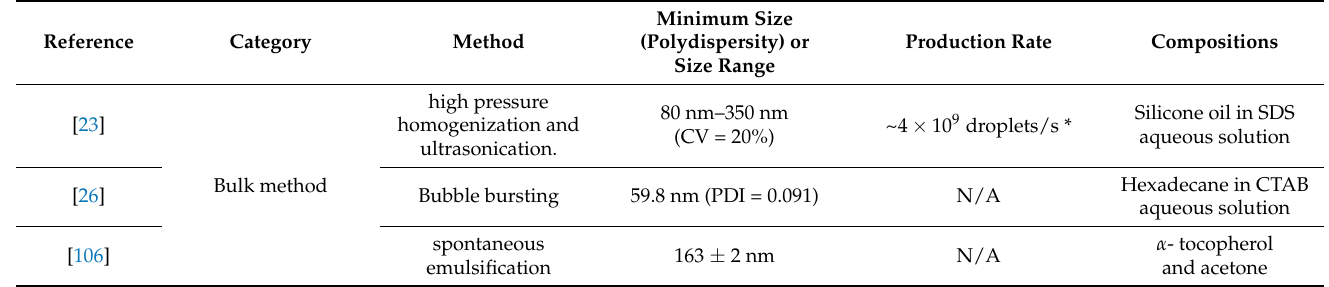
Table 1. Comparison of the methods for generating submicron droplets. (*) signifies data not explicitly presented in the reference, but are inferred by the authors based on the provided